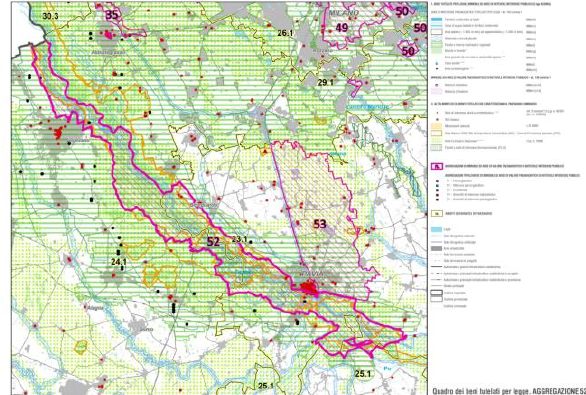
Figure 4. Aggregation 52 of bonded areas and sites regarding Ticino River Valley: landscapes preservation at National level (according to the Code of Cultural Heritage and Landscape - D.Lgs. 42/2004): in pink the landscape preservation binding actions according to art.136, in green, blue and yellow landscape preserved areas according to art 142.